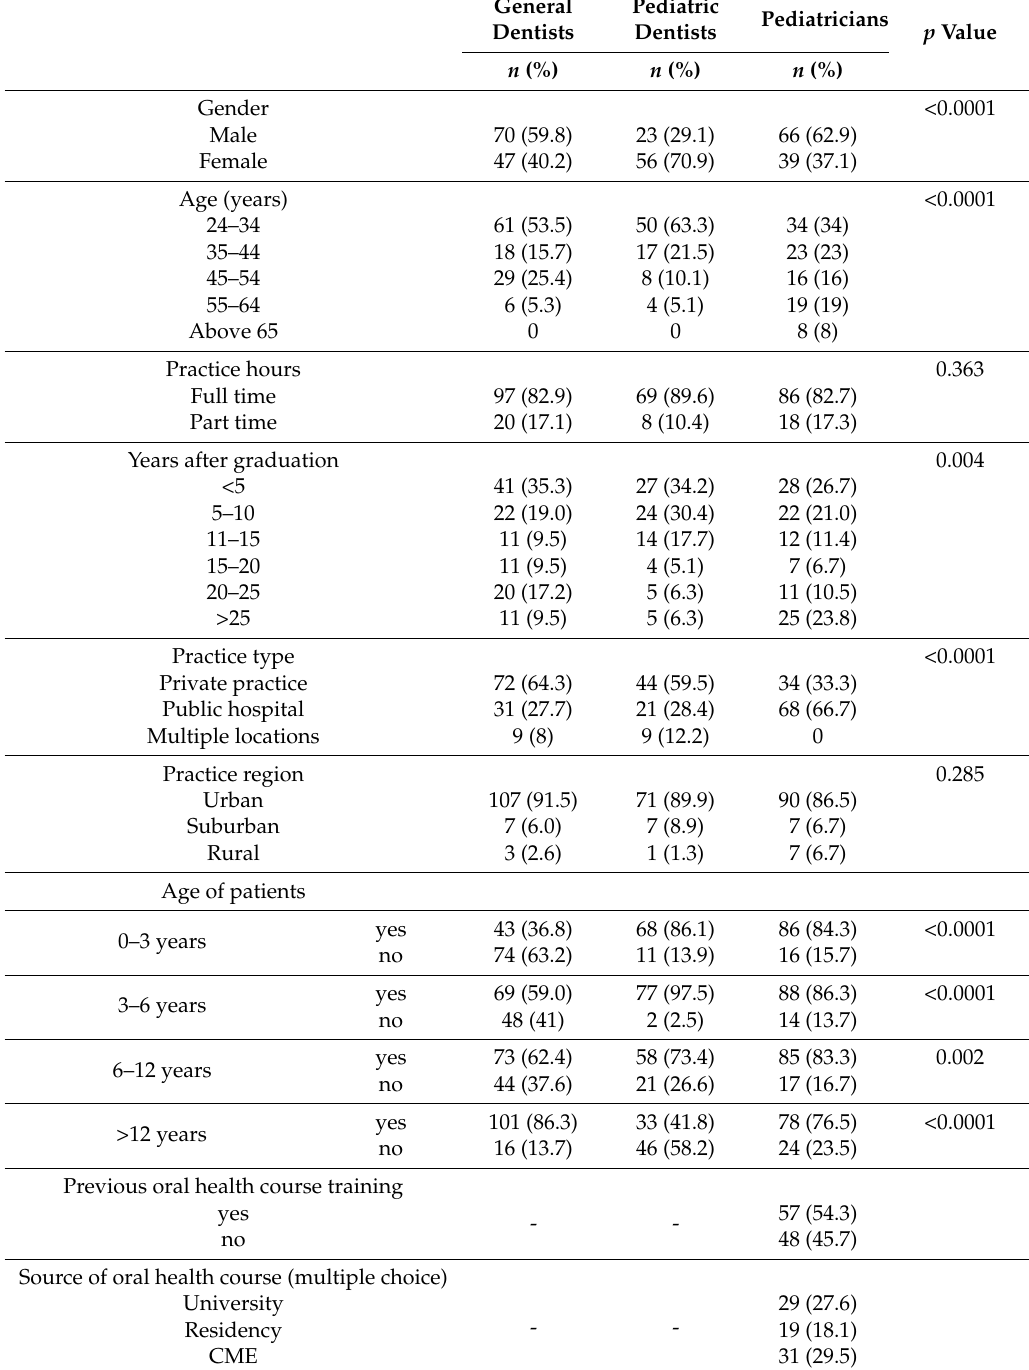
Table 1. General characteristics of the